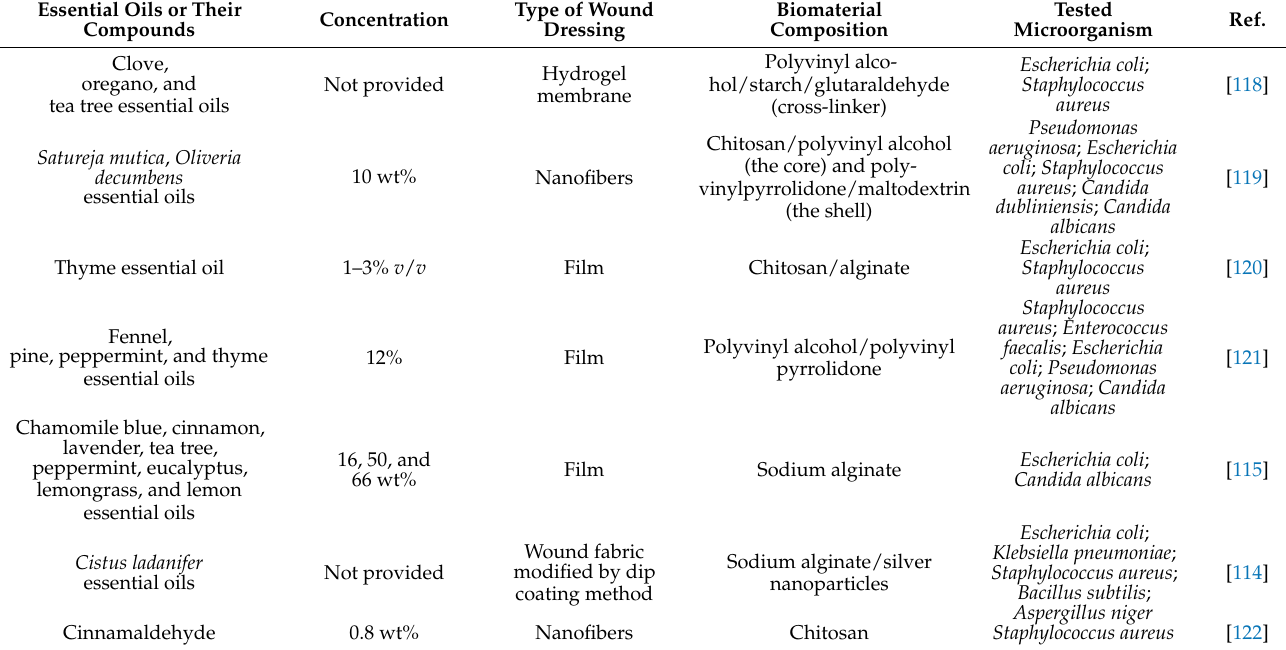
Table 7. Antimicrobial essential-oil-loaded biomaterials for wound healing